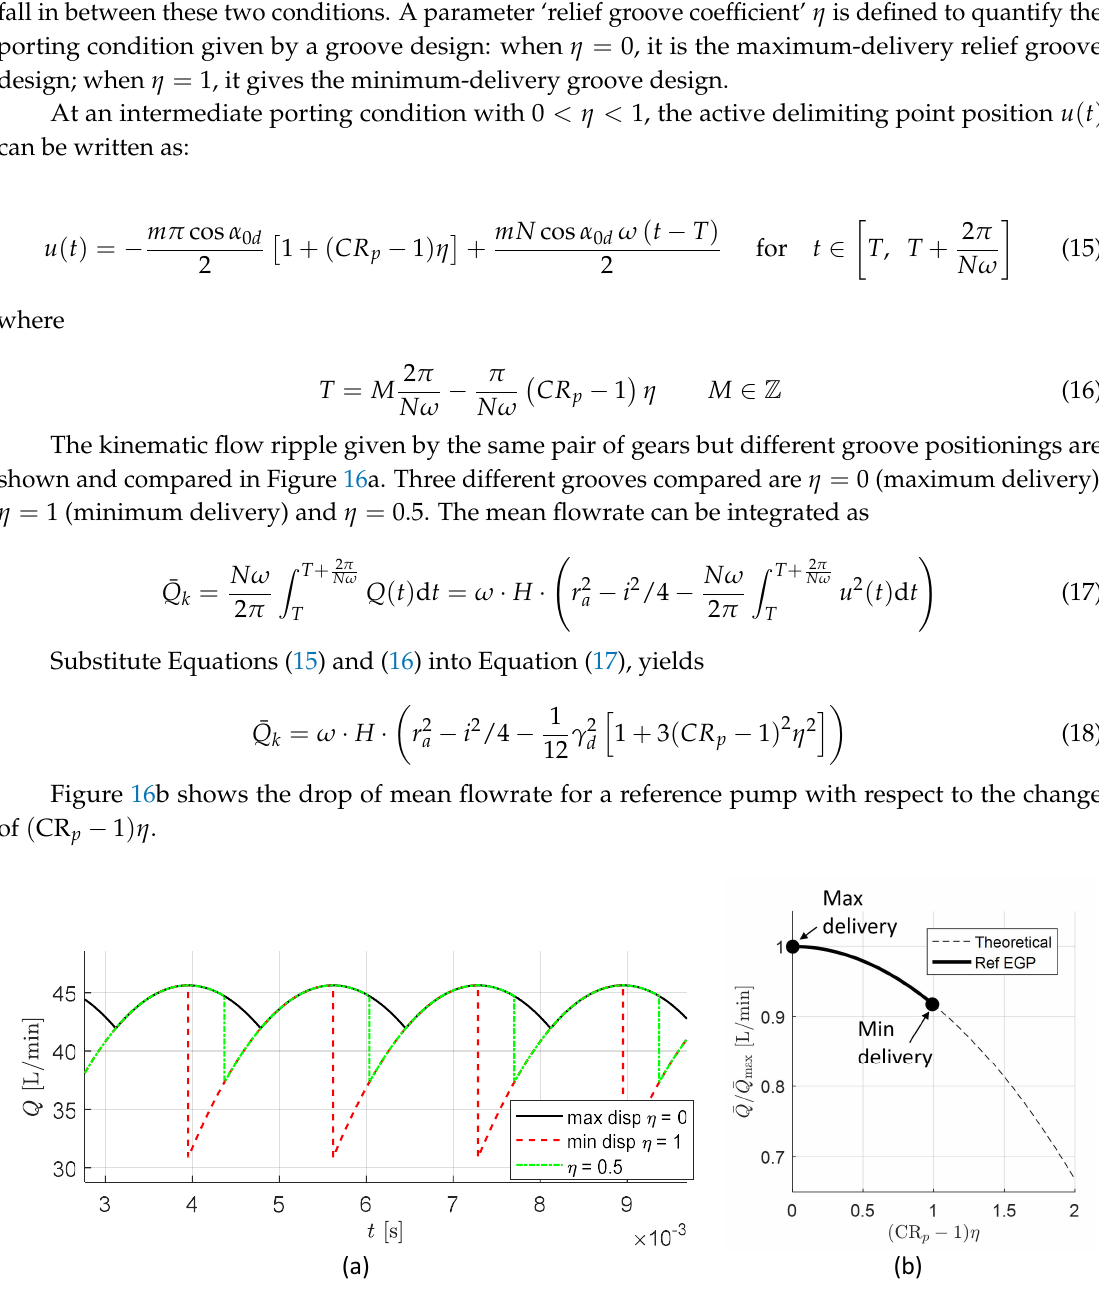
Figure 16: (a) Kinematic flow ripple (reference design, 2000 RPM) changes with different groove positionings specified by 𝜼 ; (b) the mean flowrate reduction with (cid:3435)𝑪𝑹 𝒑 −